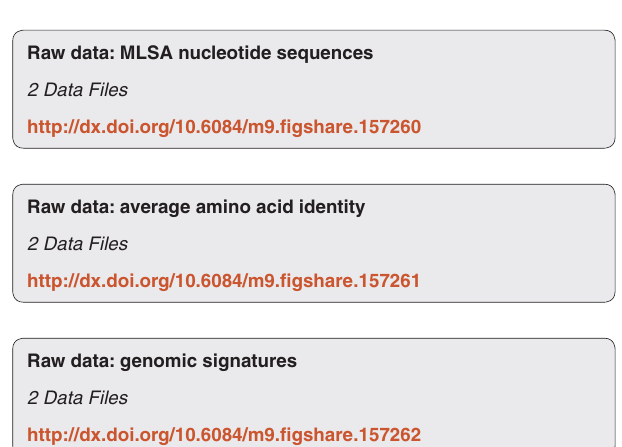
(Table 1). For instance, S. pneumoniae - S. oralis - S. mitis species